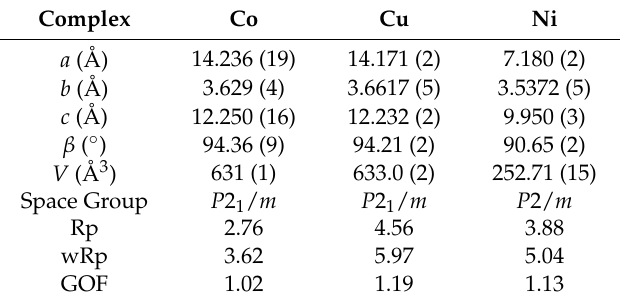
Table 3. Refined unit cell parameters obtained from the Le Bail method for